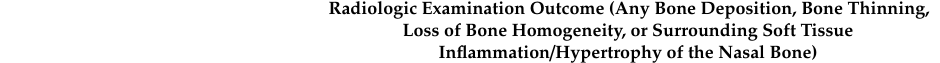
Table 3. Relationship between any radiographic lesion being noted and the exostosis physical examination findings of the nasal bones of 144